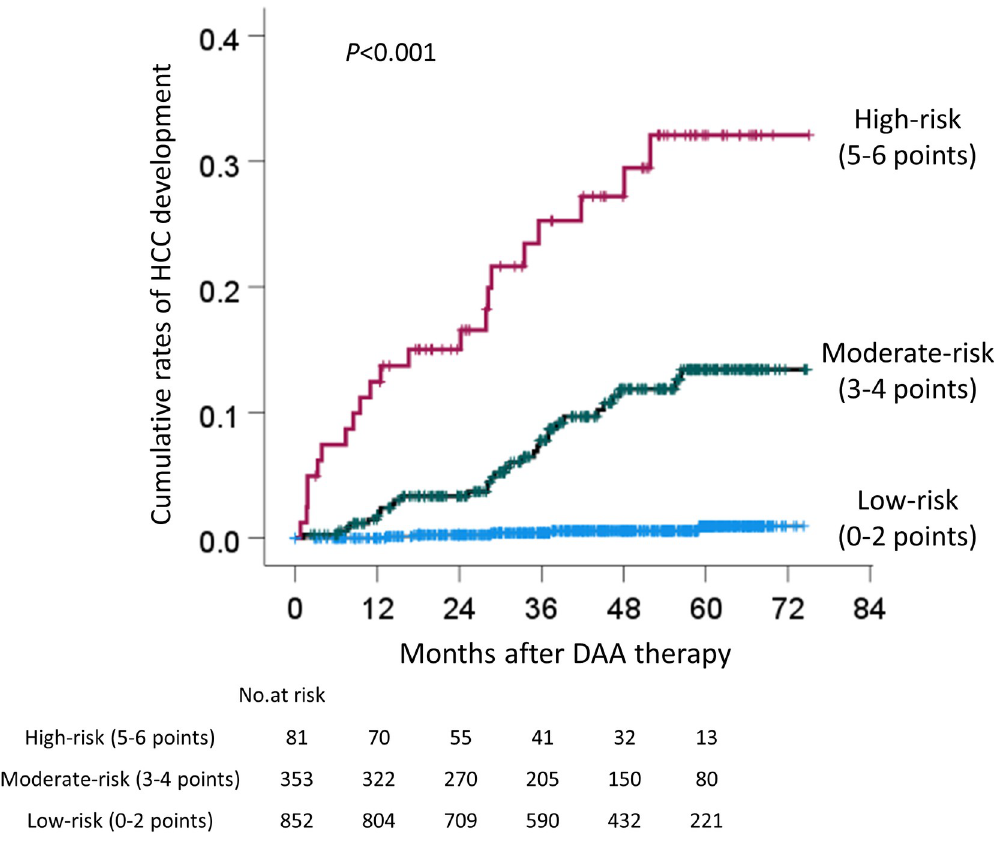
Fig 9. Development of HCC stratified by the score combining EOT-AFP, age, sex, hyaluronic acid, and EOT-Alb. EOT-AFP � 5.3 ng/mL was scored as 2 points; the others (i.e., age � 73 years, male sex, HA � 75 ng/mL, and EOT-Alb < 3.9 g/ dL) were scored as 1 point. The patients were divided into the following 3 groups according to the sum of these scores: of 0–2 points (low-risk), 3–4 points (moderate-risk), and 5–6 points (high-risk). HCC, hepatocellular carcinoma; EOT, end of treatment; AFP, α -fetoprotein; HA, hyaluronic acid; Alb, albumin. with a > 30% increase in AFP at the onset of HCC were lower in comparison to patients with EOT-AFP � 5.3 ng/mL (Table 6). In other words, in patients with EOT-AFP < 5.3 ng/mL, AFP did not increase, even if they developed HCC; thus the measurement of AFP after an SVR is unlikely to predict the development of HCC. In fact, 35% of patients who developed HCC had EOT-AFP values of < 5.3 ng/mL. There were no significant differences between the two groups with respect to tumor size, number and vascularity.In these cases, by combining HA, EOT-Alb, sex, and age, it is possible to identify patients with a high risk of HCC development (Fig 9). To the best of our knowledge, no other studies have focused on the relationship between the AFP transition and carcinogenesis. In addition, in 40.9% of patients with EOT-AFP < 5.3 ng/mL, DCP is above the upper limit at the onset of HCC (Table 6). The com- parison of the baseline characteristics of patients who developed HCC and patients who did not develop HCC revealed was no significant difference in the DCP level; thus, it is considered useful to measure DCP in the clinical course. However, it should be noted that in 37.3% of patients who developed HCC, the AFP and DCP values were both within the normal limits (Table 6). It seems difficult to predict carcinogenesis in patients who have achieved a DAA-SVR from tumor markers alone.